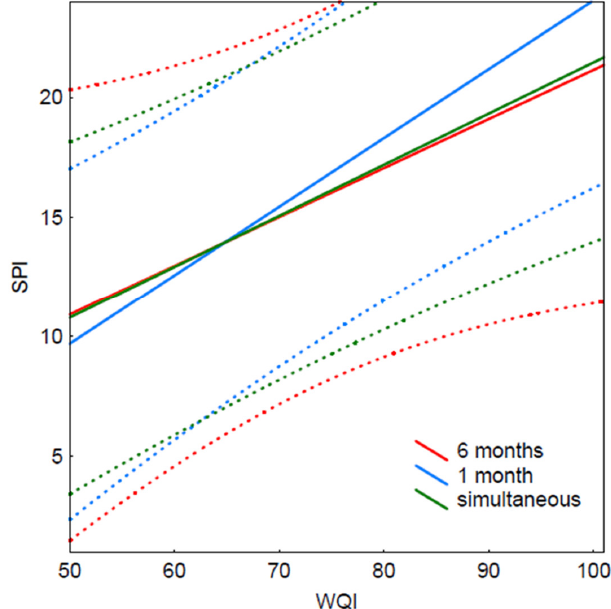
Figure 4. SPI/WQI correlation for water samples taken six months earlier vs. one month earlier vs. simultaneously with respect to diatom sampling. Dots (omitted) fitted to linear regression lines and 95% linear prediction bands.